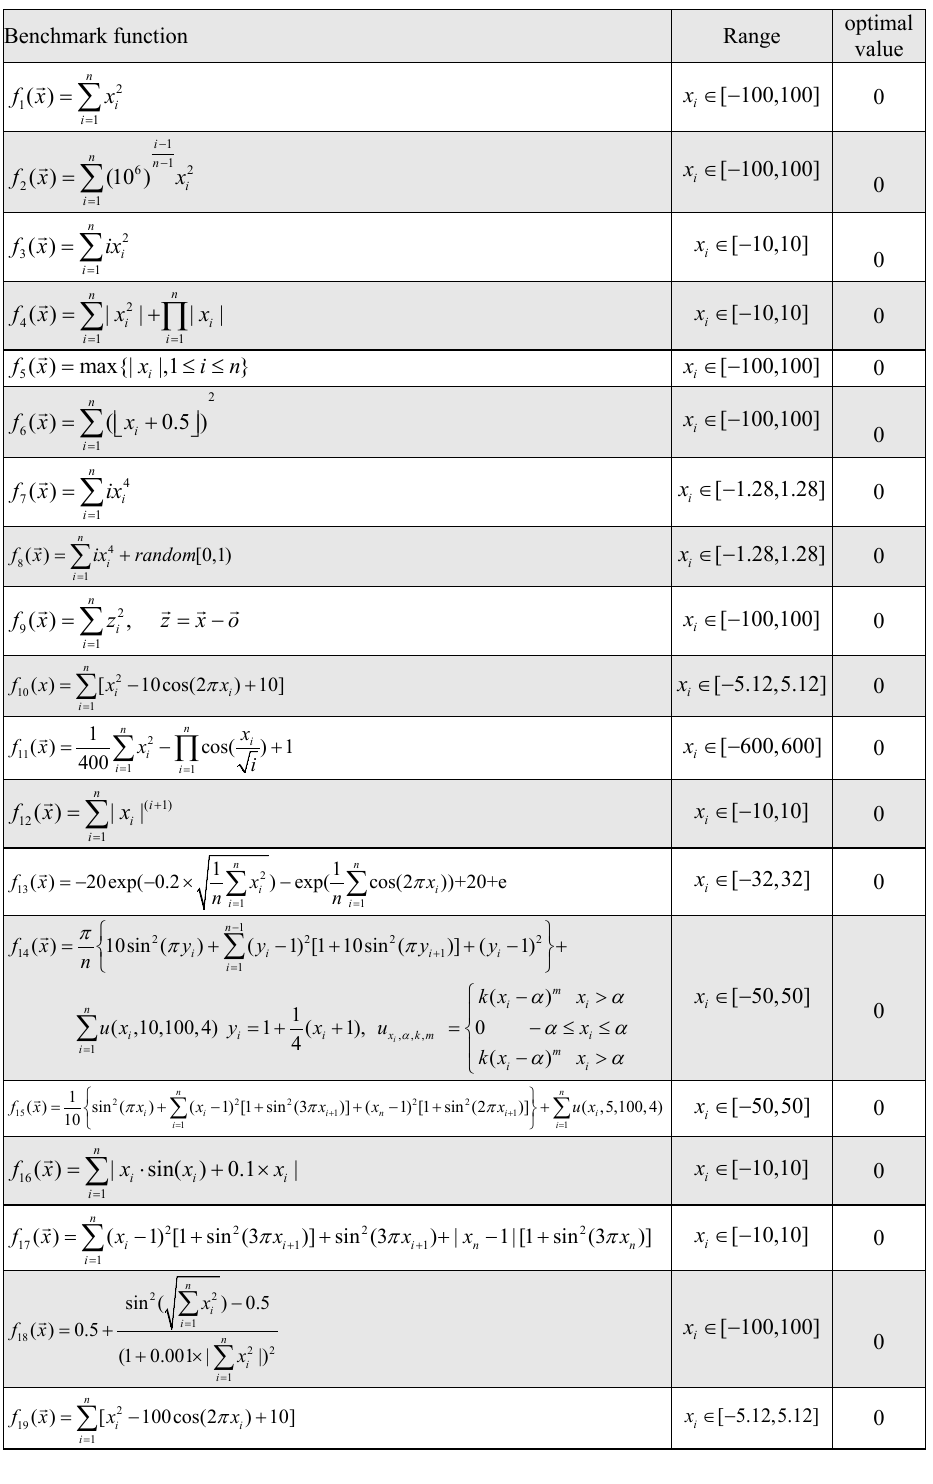
Table 1. Benchmark test